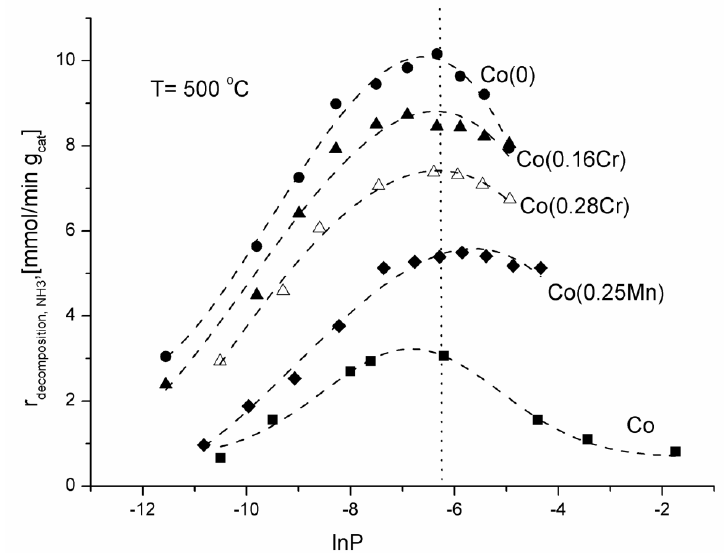
Figure 3. Dependence of the rate of the ammonia decomposition reaction on the logarithm of nitriding potential at the temperature of 500